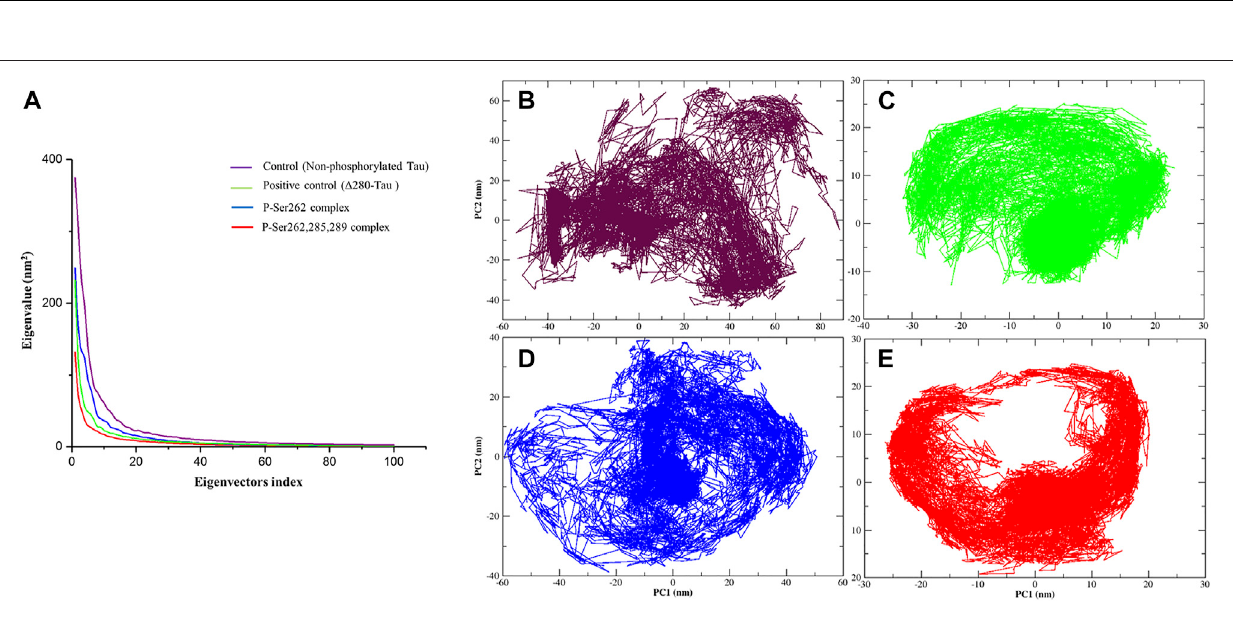
Frontiers in Molecular Biosciences |